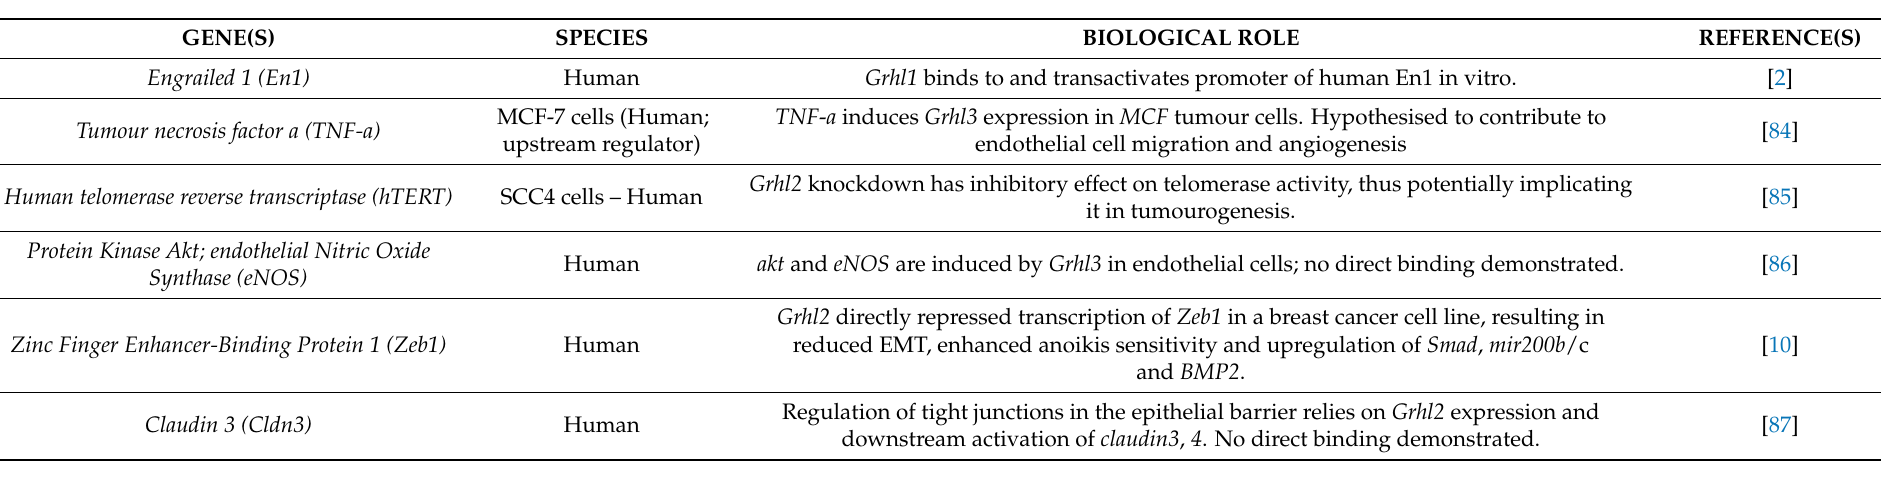
Table 4. Known or hypothesised direct target genes of the GRHL family characterised in human tissue, human cancer cell lines or other cell lines of human